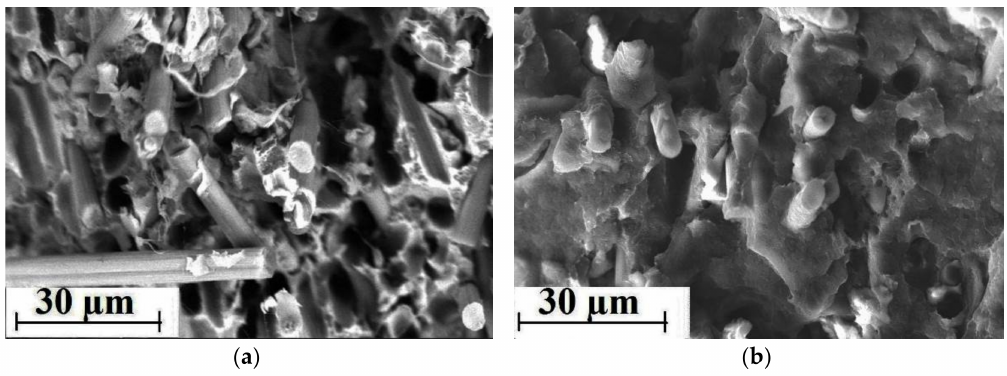
Figure 11. SEM micrographs of the permolecular structure of the three-component composites: ( a ) PPS